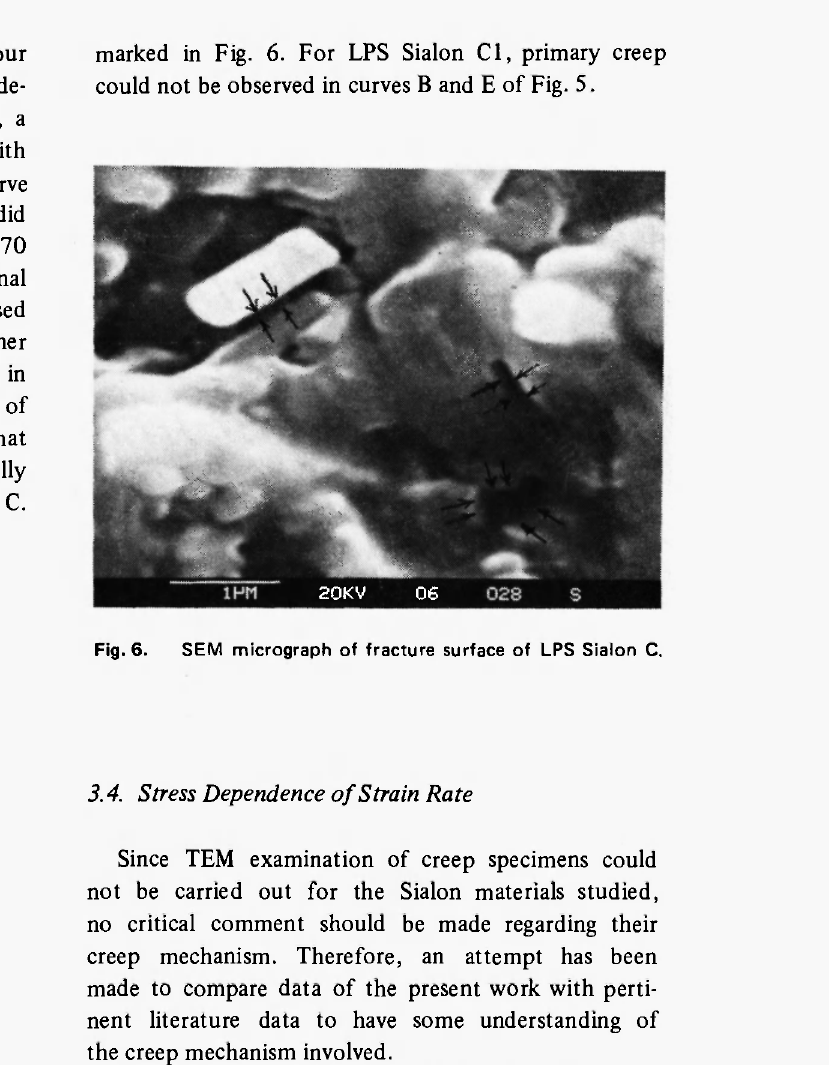
Fig. 6. SEM micrograph of fracture surface of LPS Sialon